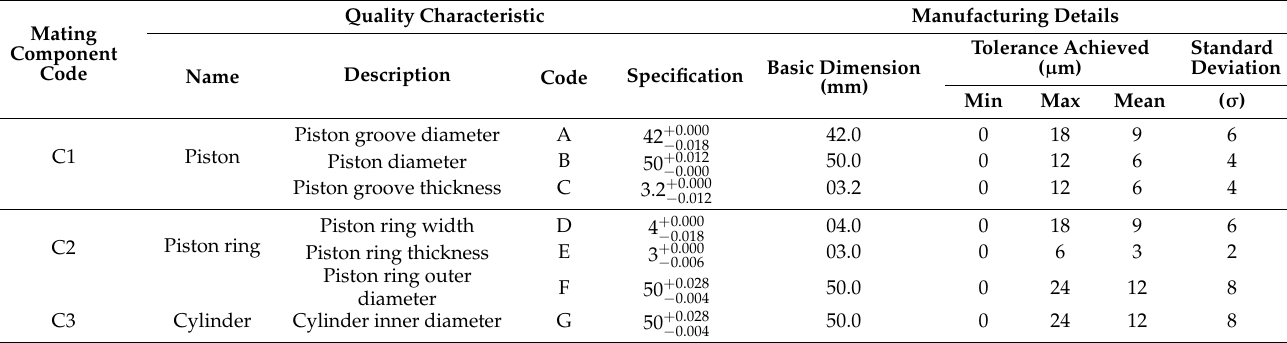
Table 1. QCs and processing parameters of each component in the